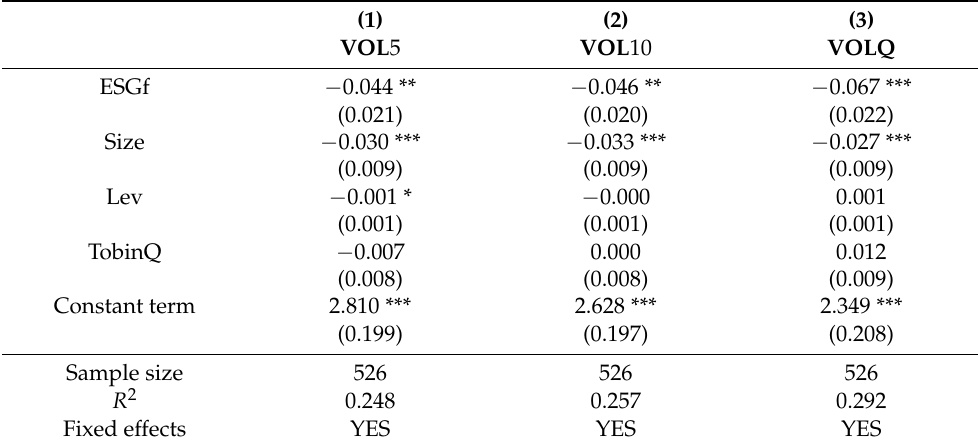
Table 4. Regression results of the volatility of companies with high and low ESG performance during